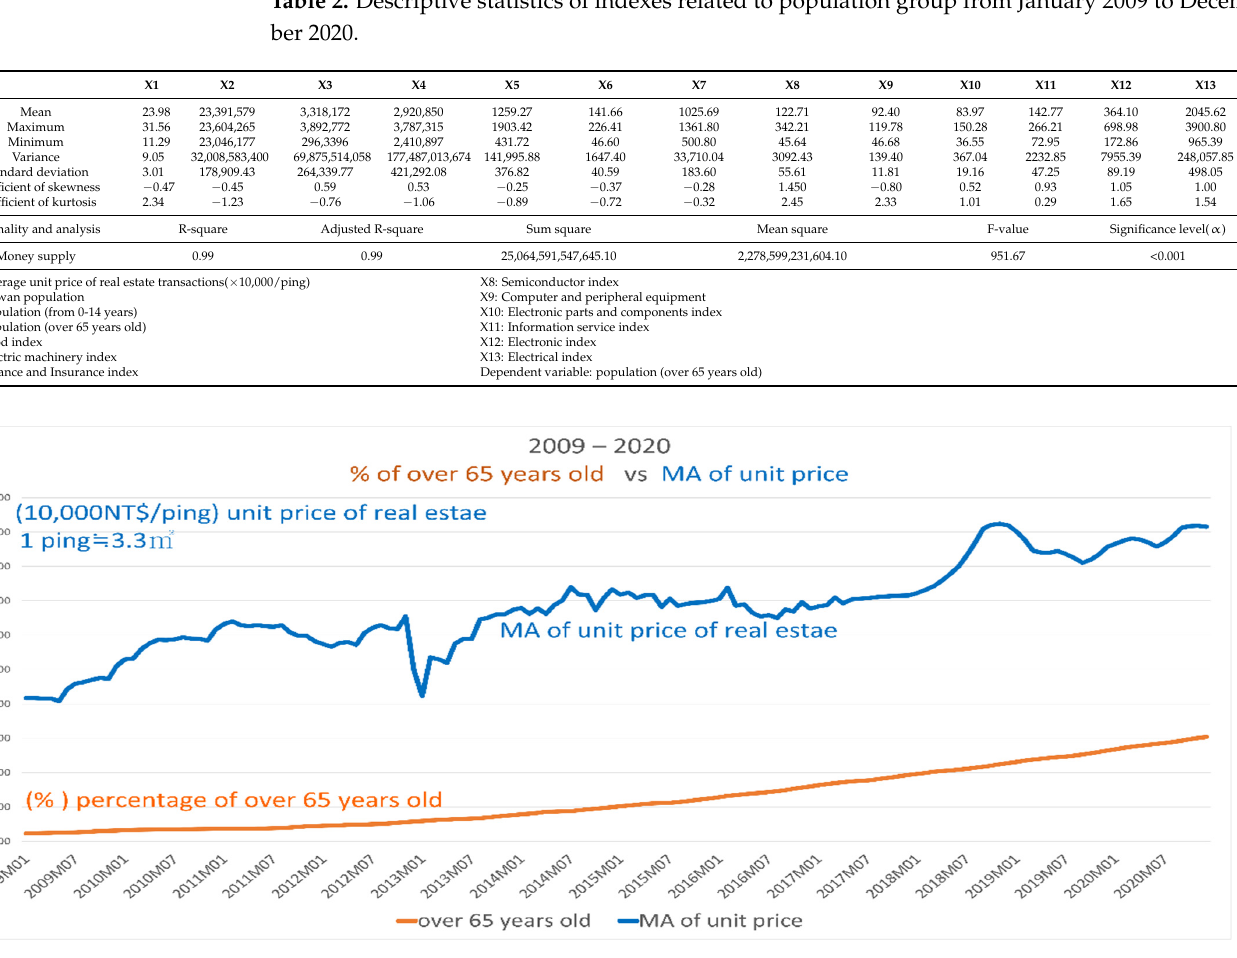
Figure 2. Monthly growth rate of people aged > 65 years with MA of unit price from 2009 to 2020. According to a report by the National Development Council of Taiwan, the super- aged (aged > 85 years) population accounted for 10.3% of the older adult population in